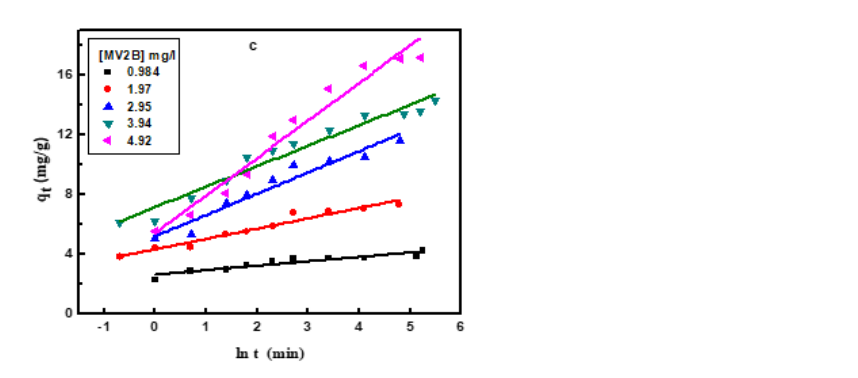
Figure 6. ( a ) Pseudo-second-order kinetics plots, ( b ) intraparticle diffusion model, ( c ) Elovich kinetic model for adsorption of MV2B on